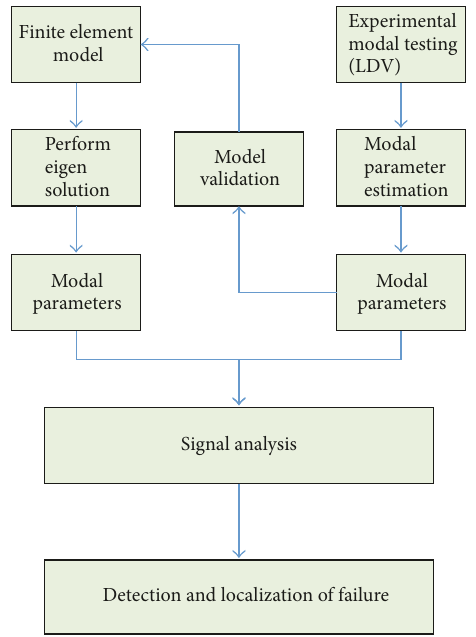
Figure 1: A scheme of a general research